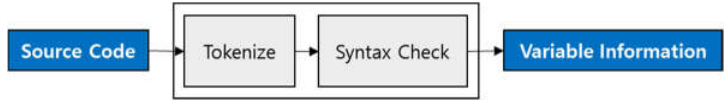
Figure 1. Vulnerability detection method by incorrect use of variable using ML.